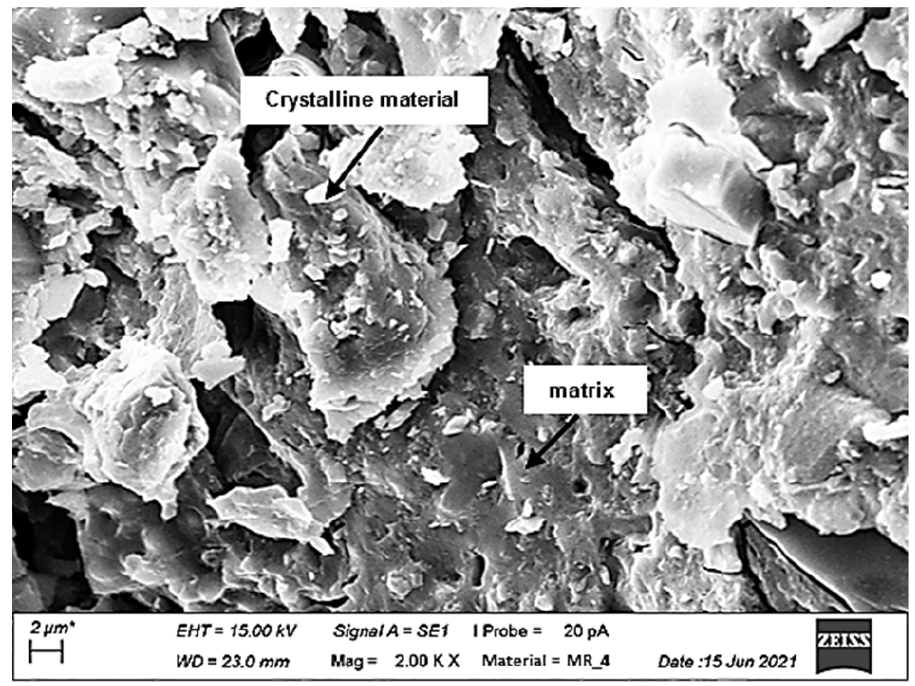
Figure 11. SEM image of the fracture surface of the brick scrap geopolymer at 2000× magnification.